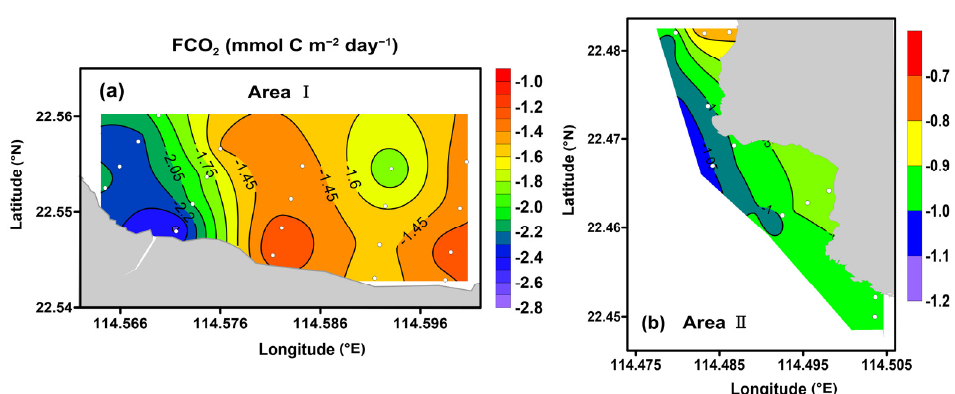
Figure A4. Averaged survey values (mean ± SD) of TAlk ( a ), DIC ( b ), pH T@ in situ ( c ), p CO 2@ in situ ( d ) and Ω A@ in situ ( e ) in the surface and bottom water of Yangmeikeng Sea Area (Area I) and Dalu Bay (Area II). The significance at p < 0.05 was marked with *.